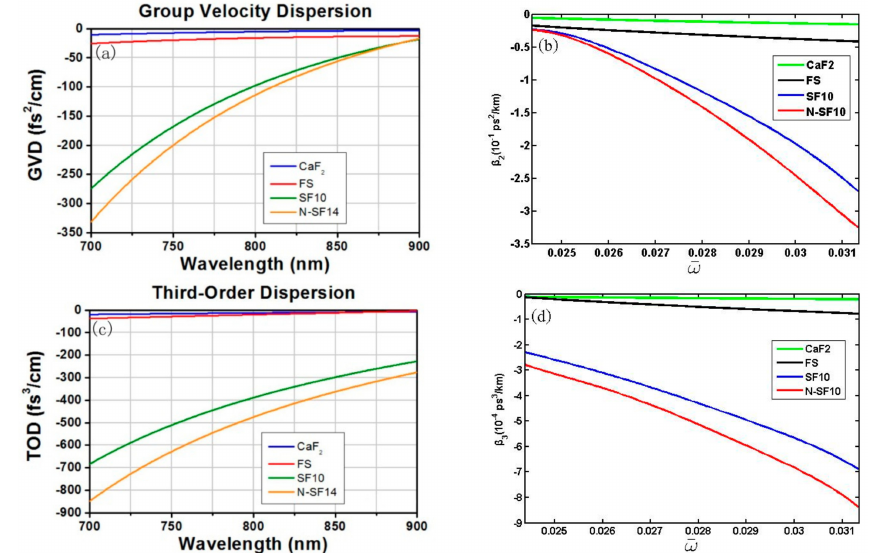
Figure 2. ( a , c ) Second- and third-order dispersions in several conventional glass verse wavelength; ( b , d ) redrawing ( a , c ) to the normalized